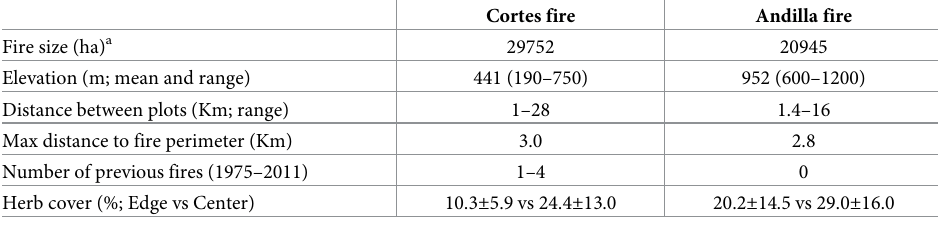
Table 1. General characteristics of the study plots in each burnt area.